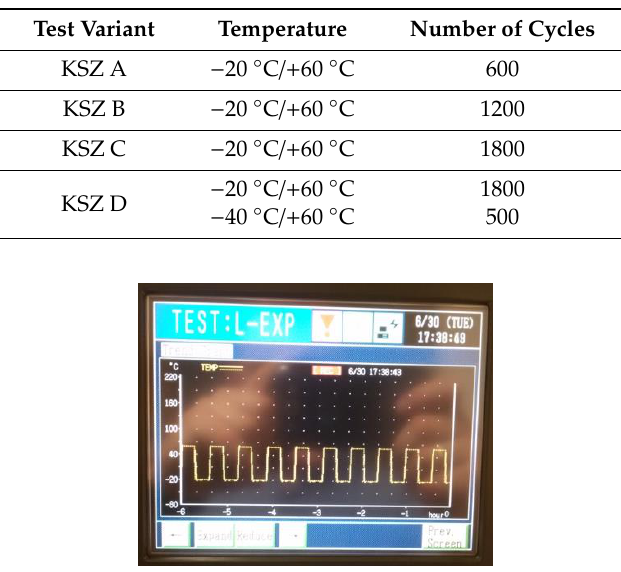
Table 5. Results for mechanical properties (DIN EN 10002-1) of reference samples. Results